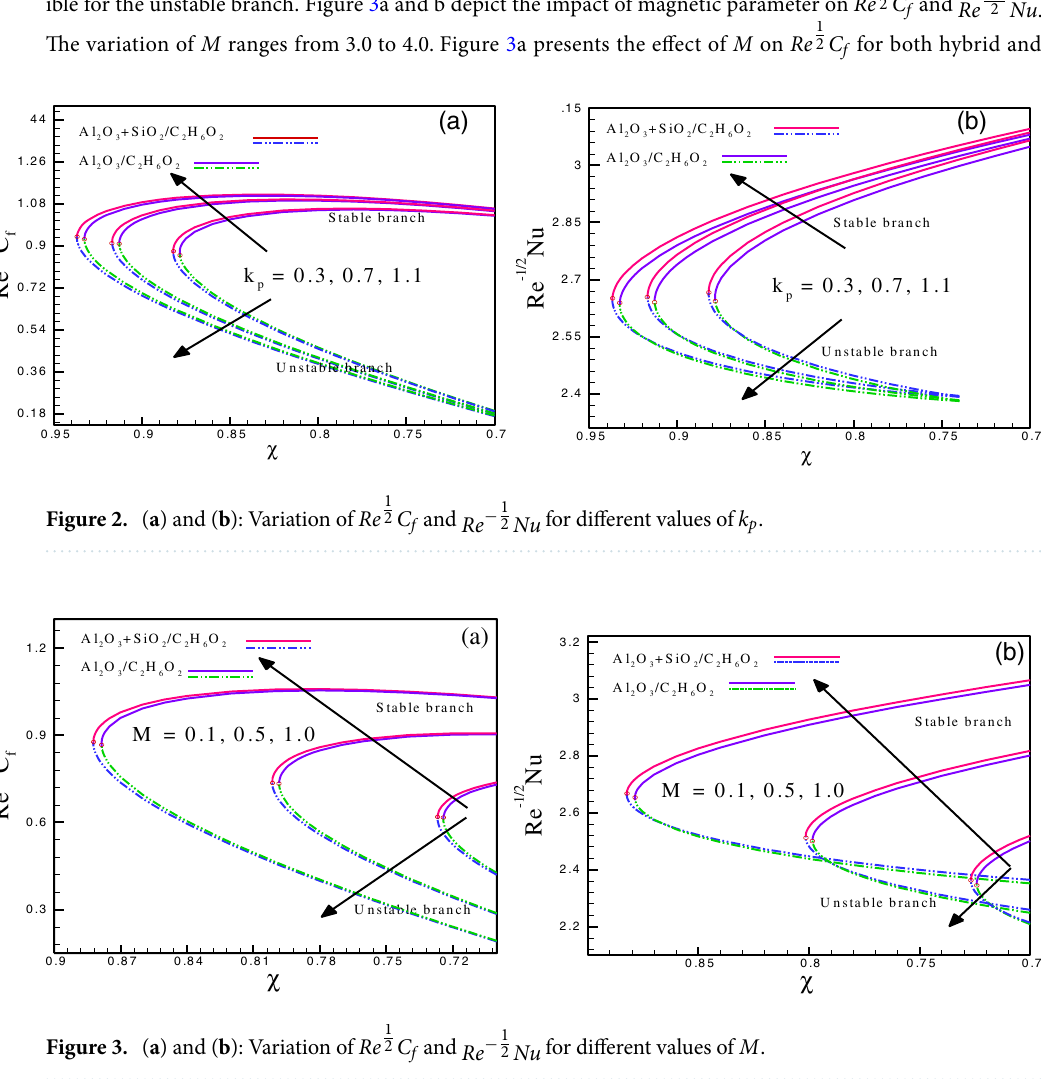
Figure 3. ( a ) and ( b ): Variation of Re